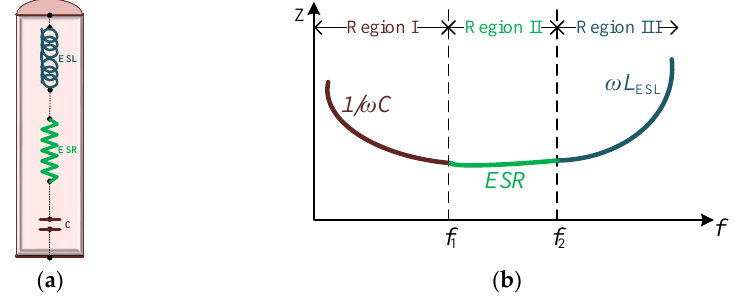
Figure 2. ( a ) Simplified circuit and ( b ) impedance by region.